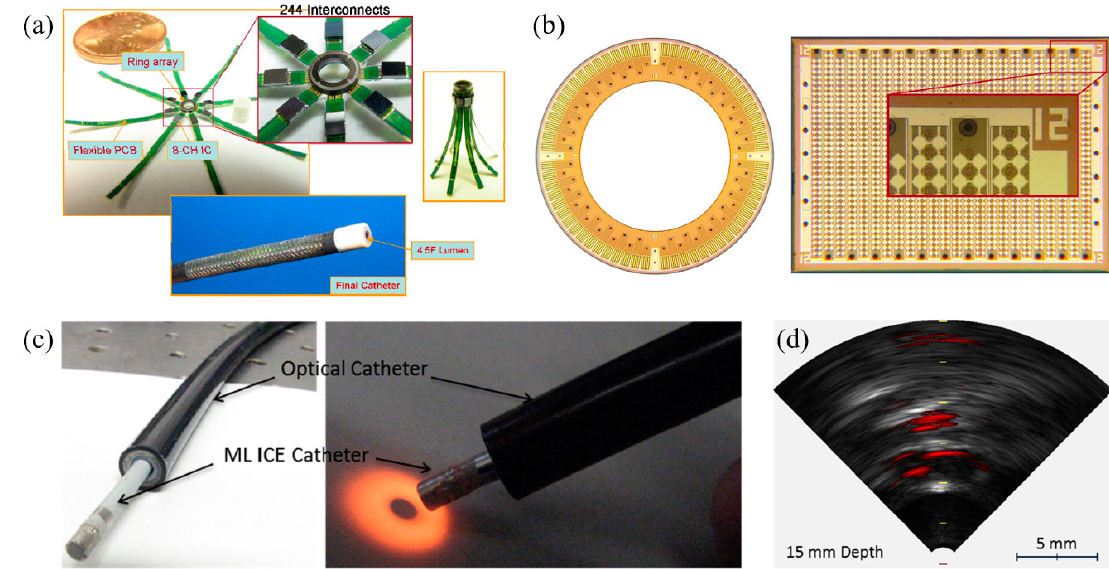
Figure 29. ( a ) Assembled ring cMUT array-based catheter (Reproduced with permission from IEEE [175]). ( b ) Optical pictures of ring and microlinear cMUT arrays (Reproduced with permission from IEEE [175]). ( c ) Assembled microlinear cMUT array-based photoacoustic catheter (Reproduced with permission from IEEE [176]). ( d ) Photoacoustic image of mouse subcutaneous kidney model (Reproduced with permission from IEEE [176]).